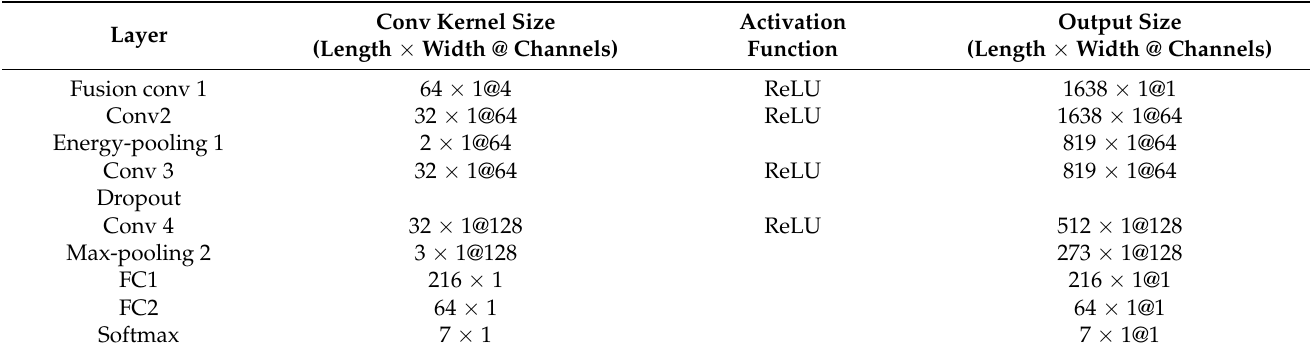
Table 1. MF-CNN model structure parameters.